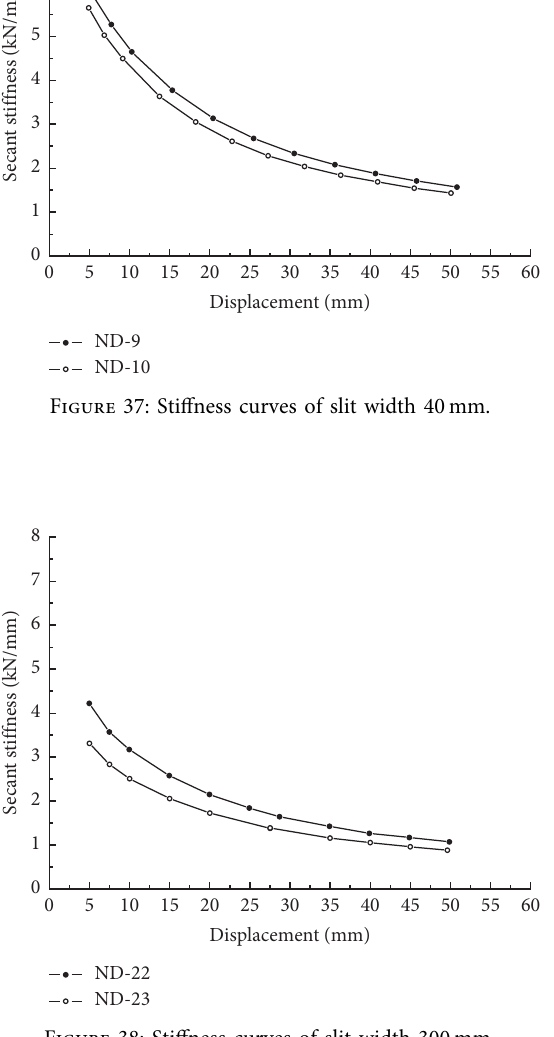
Figure 38: Stiffness curves of slit width 300mm.